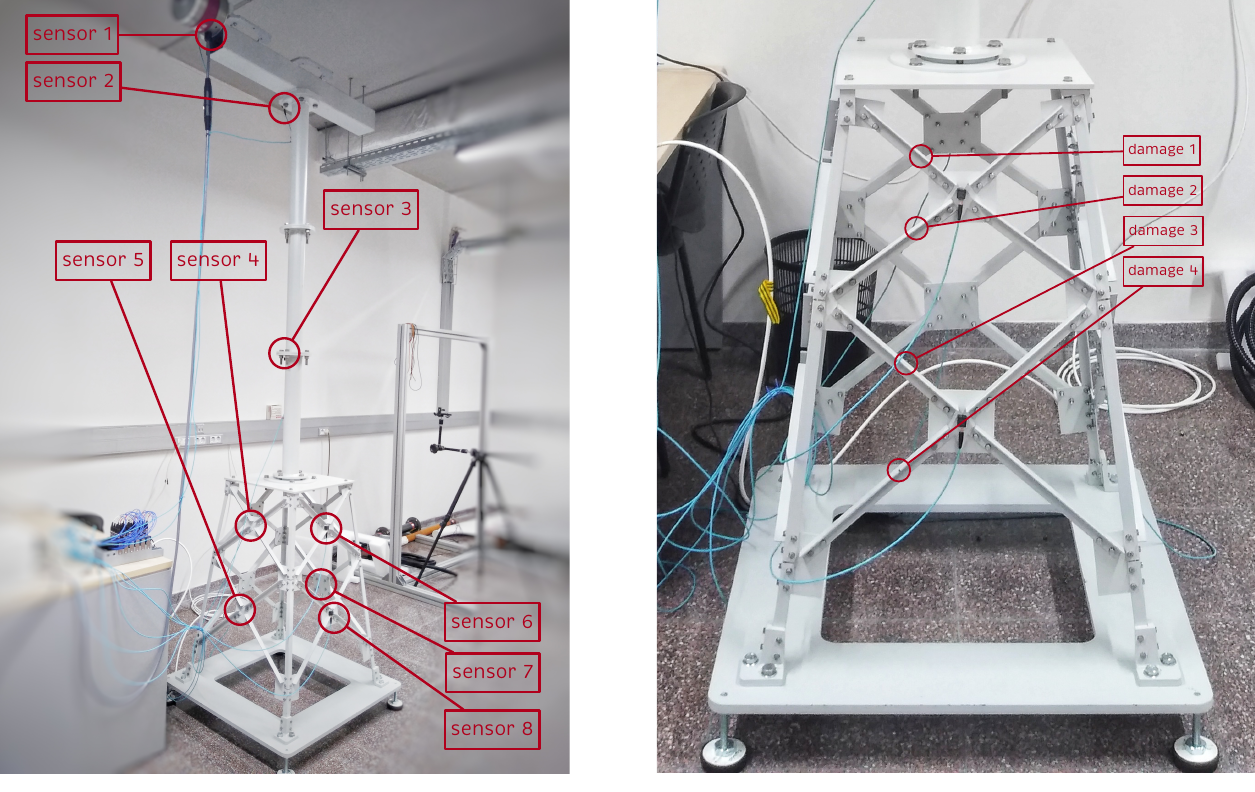
Figure 3. Small-scale wind-turbine